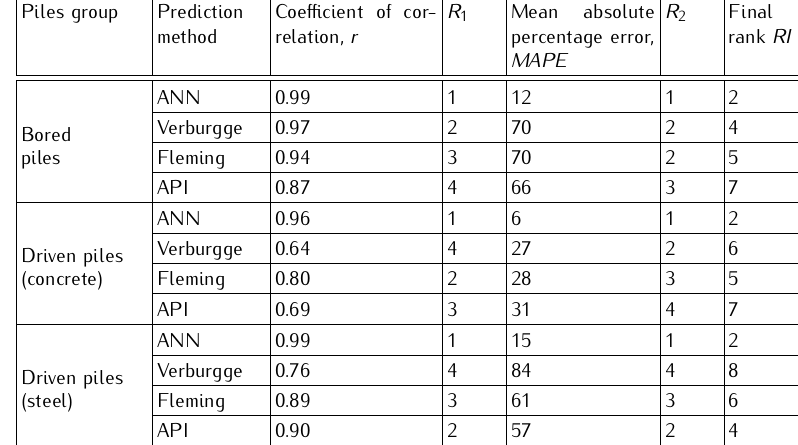
Table 5. Performance of the ANN models versus the load-transfer